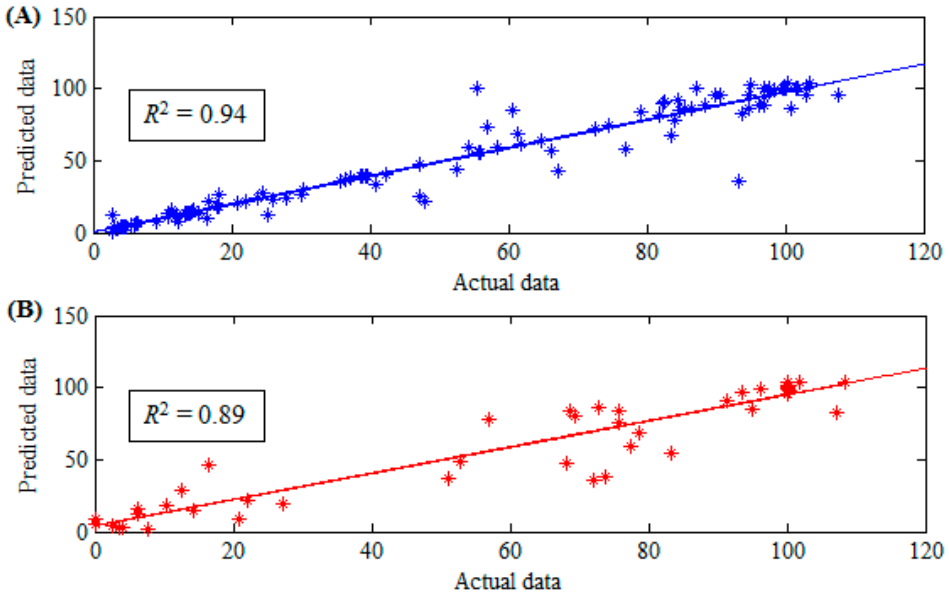
Figure 4. Plots of the correlation coefficients for the training ( A ) and testing; ( B ) subsets.